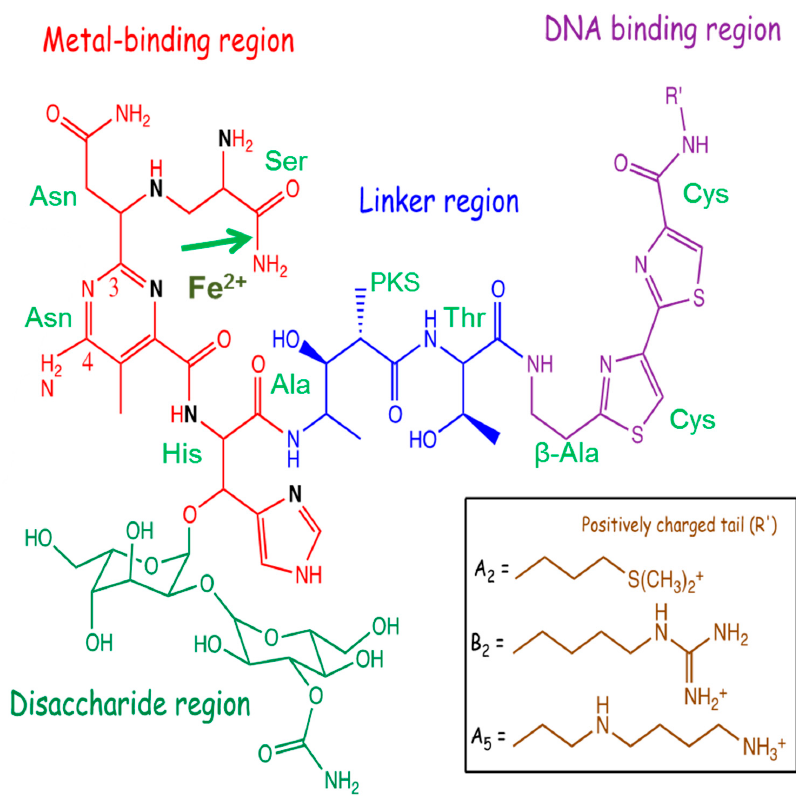
Figure 1. The structure of bleomycin with the four functional domains indicated. The precursor amino acids are shown as well as the propionate moiety derived from polyketide synthases (PKS). The positively charged tails (R ′ ) are shown for the various bleomycin congeners. The green arrow indicates the site of bleomycin hydrolase cleavage. The figure is adapted from [15] and reprinted by permission from Springer Nature.